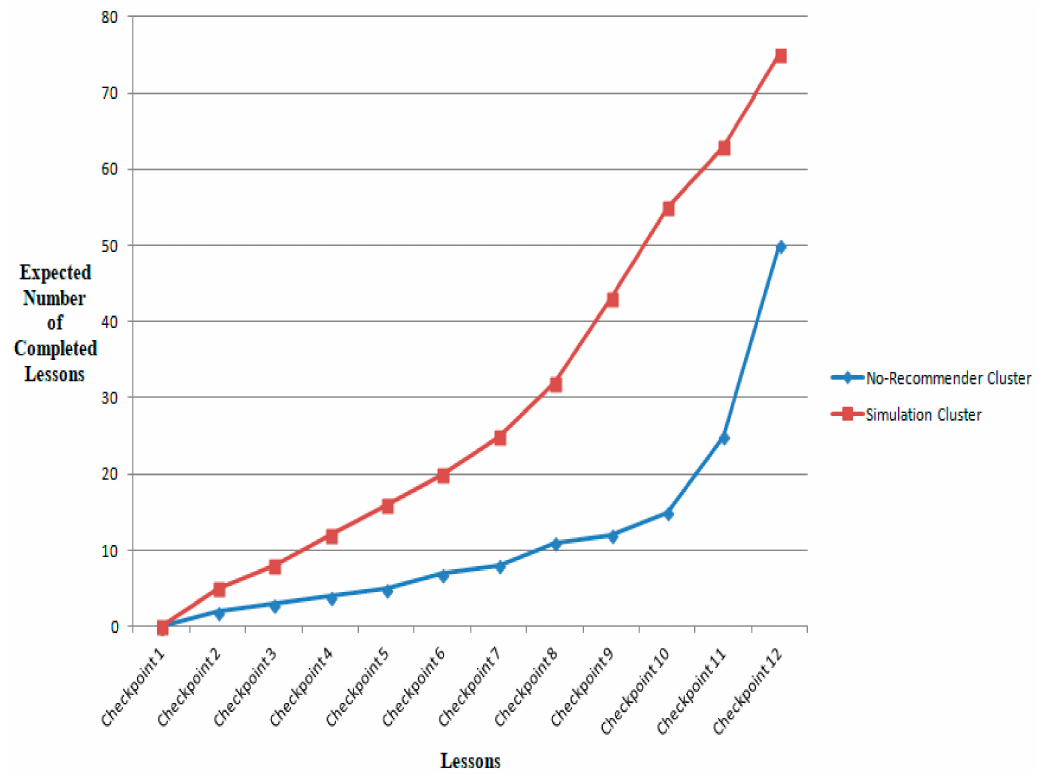
Figure 11. Expected number of completed lessons for no-recommender versus simulation